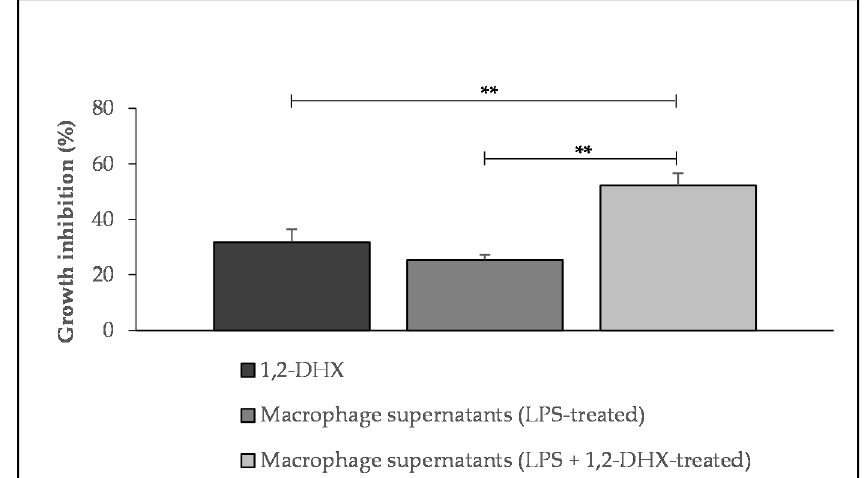
Figure 2. Effect of 1,2-dihydroxyxanthone (1,2-DHX; 50µM), lipopolysaccharide (LPS)-stimulated macrophage supernatants, and 1,2-DHX-conditioned LPS-stimulated macrophage supernatants on A375-C5 melanoma cell line growth. Results show mean values ± SEM (n ≥ 3). ** p < 0.05.